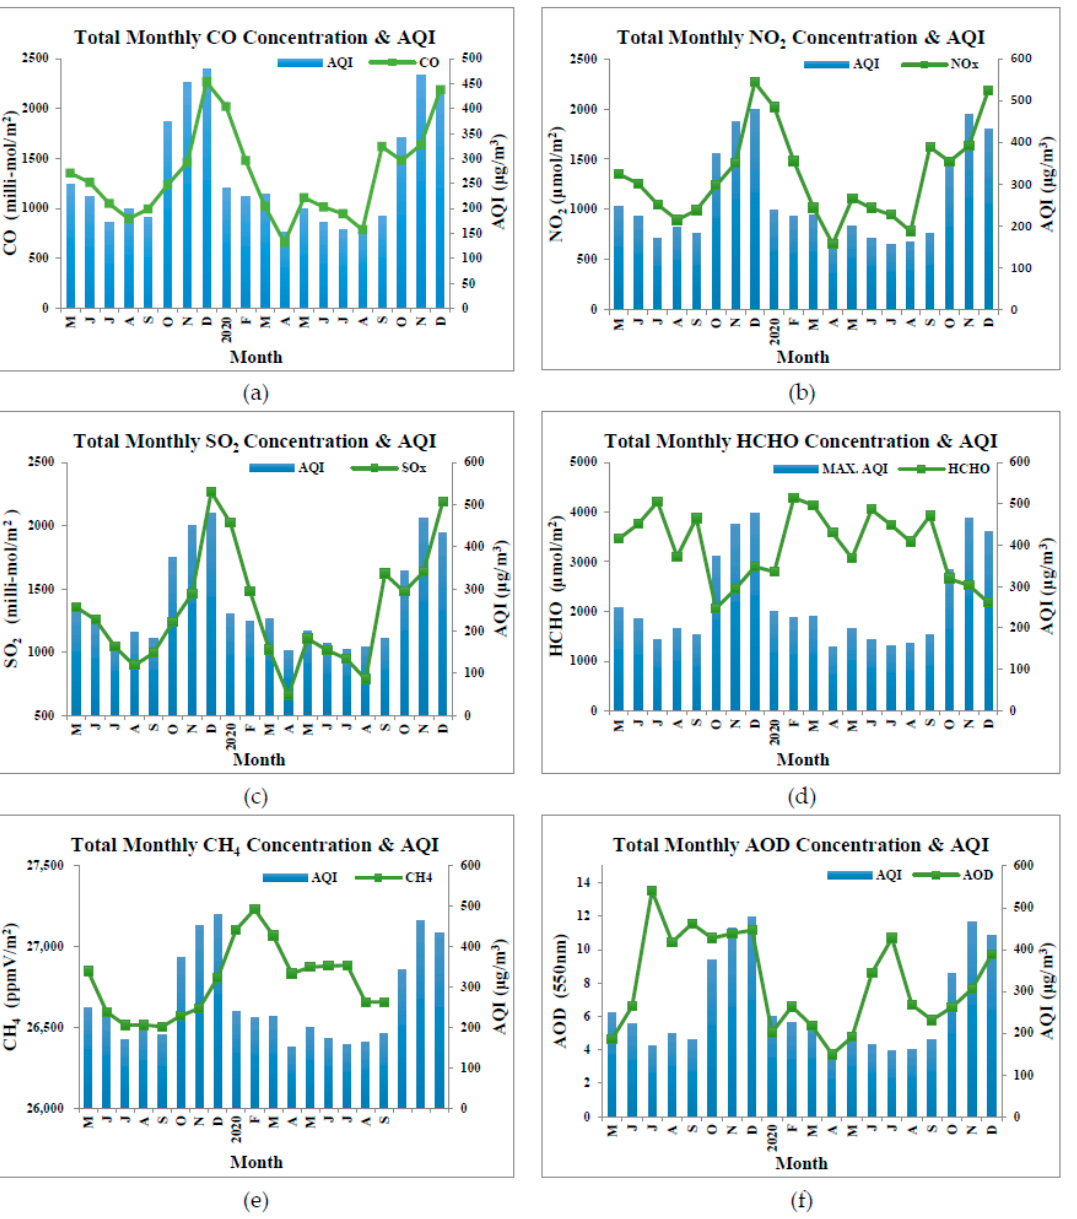
Figure 3. Total monthly contribution of different pollutants and their relevancy to maximum AQI in Lahore, from March 2018 to December 2020: ( a ) CO, ( b ) NO 2 , ( c ) SO 2 , ( d ) HCHO, ( e ) CH 4 , ( f )